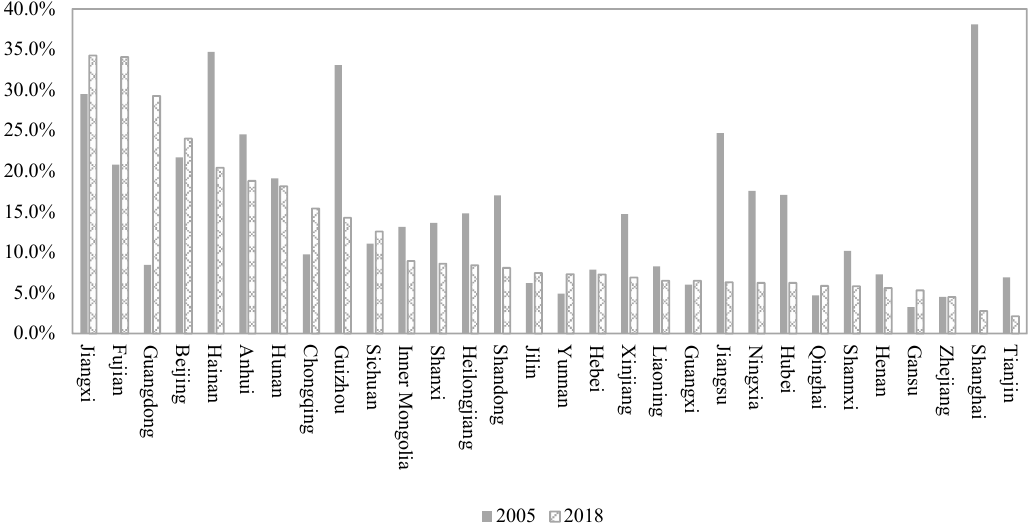
Figure 2. The unmet medical demand across China’s provinces.